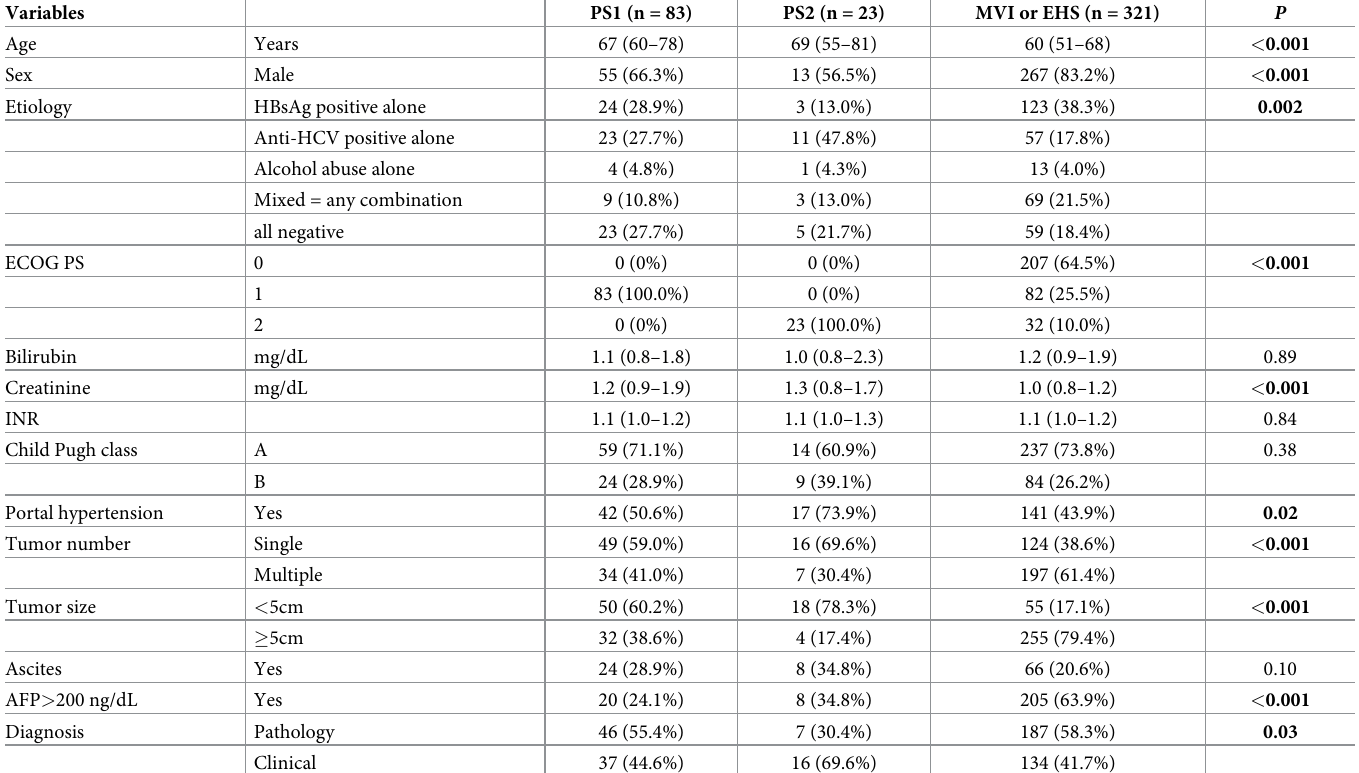
Table 1. Demographic and clinical characteristics of the patients with advanced (BCLC C) HCC (N = 427). Variables